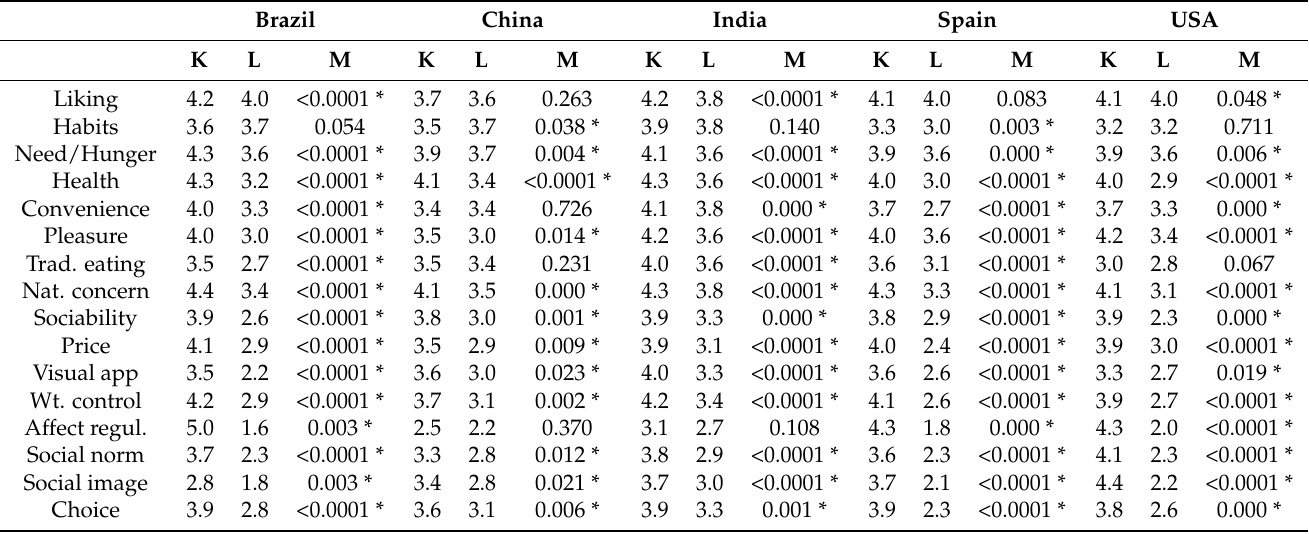
Table A11. Mean scores1 for RATA and RATING survey formats and p -values for the corresponding two-sample t -test for each motivation construct for starch-rich foods in all five countries.